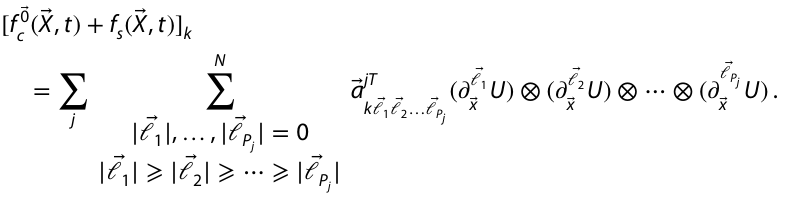
4 The nonlinear f ⃗ 0